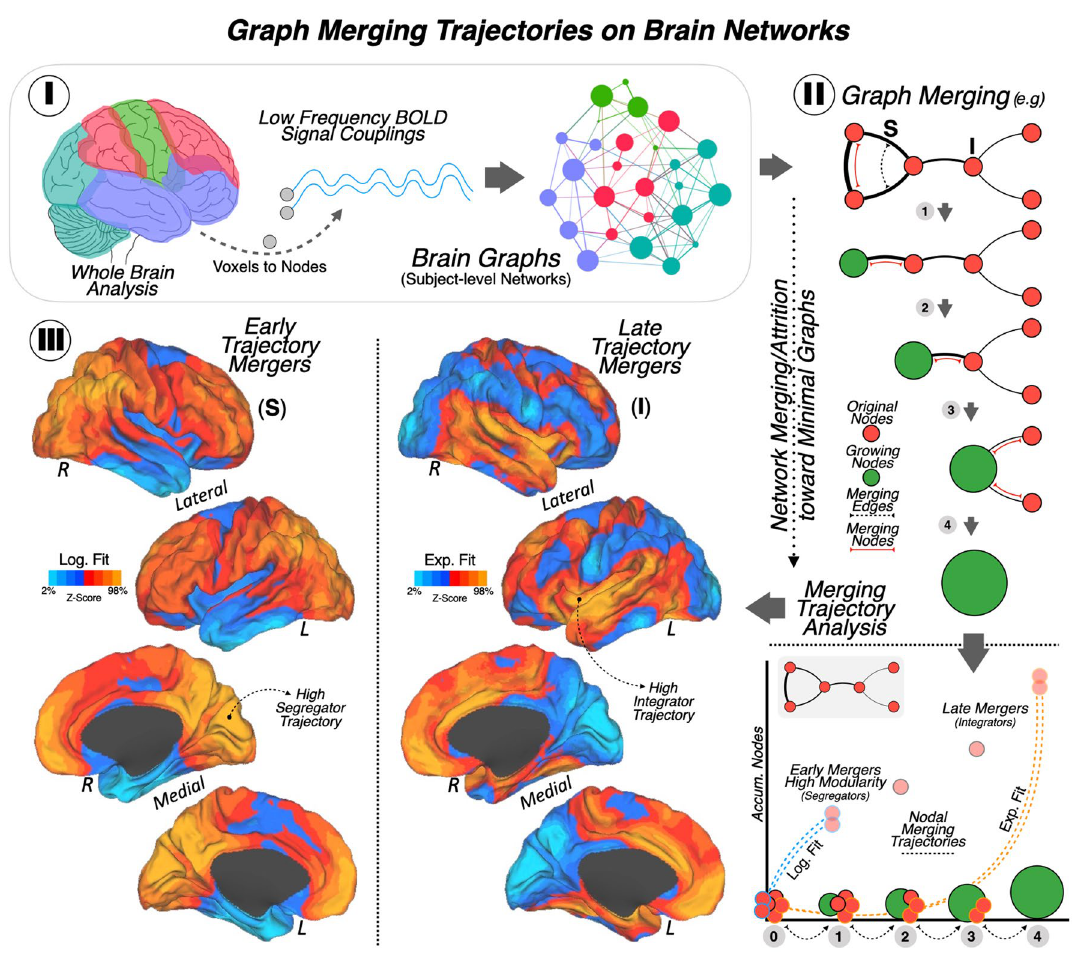
Figure 1. Graph merging trajectories on brain networks (I) Neuroimaging data. Whole-brain functional MRI data measured as low frequency blood oxygenation level-dependent signal couplings of the cerebral cortex were recorded at the voxel level. Graph functional connectivity analysis at the node level was conducted, obtaining connectivity networks at the subject level. (II) Connectomics analyses. An example of our graph merging analysis approach is depicted (upper part in II), illustrating spatiotemporal organization changes in the brain functional networks. (1) Brain nodes, which are prone to be segregated into locally interconnected subsystems ( segregating nodes or S ), (2) progressively blend with other discrete nodes by means of interacting with the merging nodes ( integrating nodes or I), (3) until integrating themselves into complex systems (i.e., growing nodes ), (4) and finally result in organized large-scale networks or brain systems. The merging trajectory analysis (lower part in II) allows for the investigation of the reorganization of the human brain functional networks from a more segregated to a more integrated state. This analysis was based on implementing logarithmic and exponential curve fitting models after investigating the cumulative node-to-node relations, making it possible to differentiate brain regions prone to merge earlier from those likely to blend later. (III) Topological representations. Brain maps projections reflecting the networks’ spatial distribution after applying the graph merging trajectory analysis to the functional connectivity human brain data: on the left, the early trajectory mergers or the segregating nodes were discriminated after implementing a logarithmic curve fitting model; on the right, the late trajectory mergers or the integrating nodes were differentiated from the early ones after using an exponential curve fitting model. Note : All the individual and group-level analyses were done adopting a whole-brain voxel-level approach and all of them were corrected for multiple comparisons using a False Discovery Rate approach (voxel-wise FDR q < 0.05). BOLD Blood oxygenation level-dependent, S Segregating node, I Integrating node, Log. Fit Logarithmic curve fitting model, Exp. Fit Exponential curve fitting model, R Right hemisphere, L Left the upper-bound (+ 1.96 SD), we identified 400 genes with transcriptomic expression associated with the late mergers or integrating nodes (see Fig. 2-I; the list of genes associated with the lower or upper bound appear in Supplementary materials Tables 1 and 2). The specific cellular functional components of genes were identified using Gene Ontology (FDR-corrected q < 0.05); see in Fig. 2-II; the list of cellular components linked to the lower or the upper bound of the probability distribution, and the list of genes associated with each cellular component appear in Supplementary materials Tables 3, 4, 5 and 6. Bearing in mind the purpose of this work, after con-